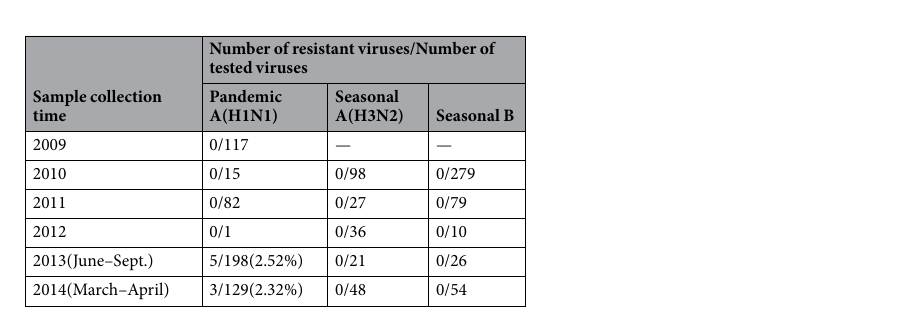
Table 3. The yearly distribution of viruses with highly-reduced sensitivity to oseltamivir from 2009 to 2014 in Guangdong. “—”“ = “Not